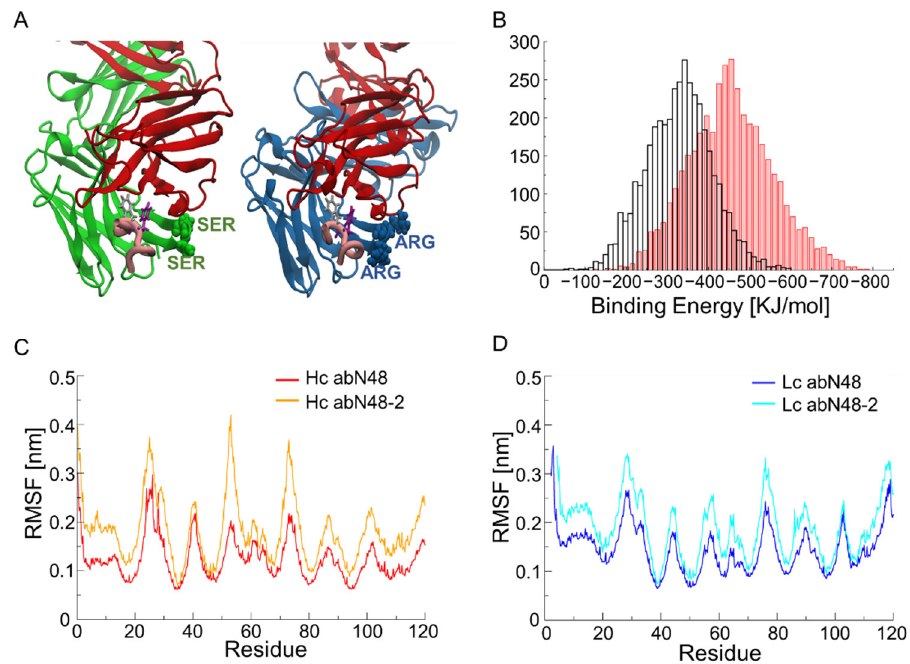
Figure 3. Details of molecular dynamics simulation of abN48 and abN48-2. ( A ) Illustration of abN48 and abN48-2 FABs and their interaction with pepN9-19 (colored in pink; Phe14 and Trp15 are shown in gray and purple, respectively). The two antibodies shared the same light chain (in red) while the heavy chains differed only for two residues (two serines of CDR3 of abN48 were mutated in arginines in abN48-2). ( B ) Histogram of the binding energy computed using MM-PBSA on the abN48-pCXCR2 complex (black) and abN48-2-pCXCR2 complex (red). The two distributions had clear separate picks and the t-test showed a p -value << 0.05. Root-mean-square fluctuation (RMSF) of abN48 and abN48-2 heavy chains ( C ) and light chains ( D ). The maturated antibody showed higher fluctuations than the original one, in agreement with the β factor of the crystal structure.